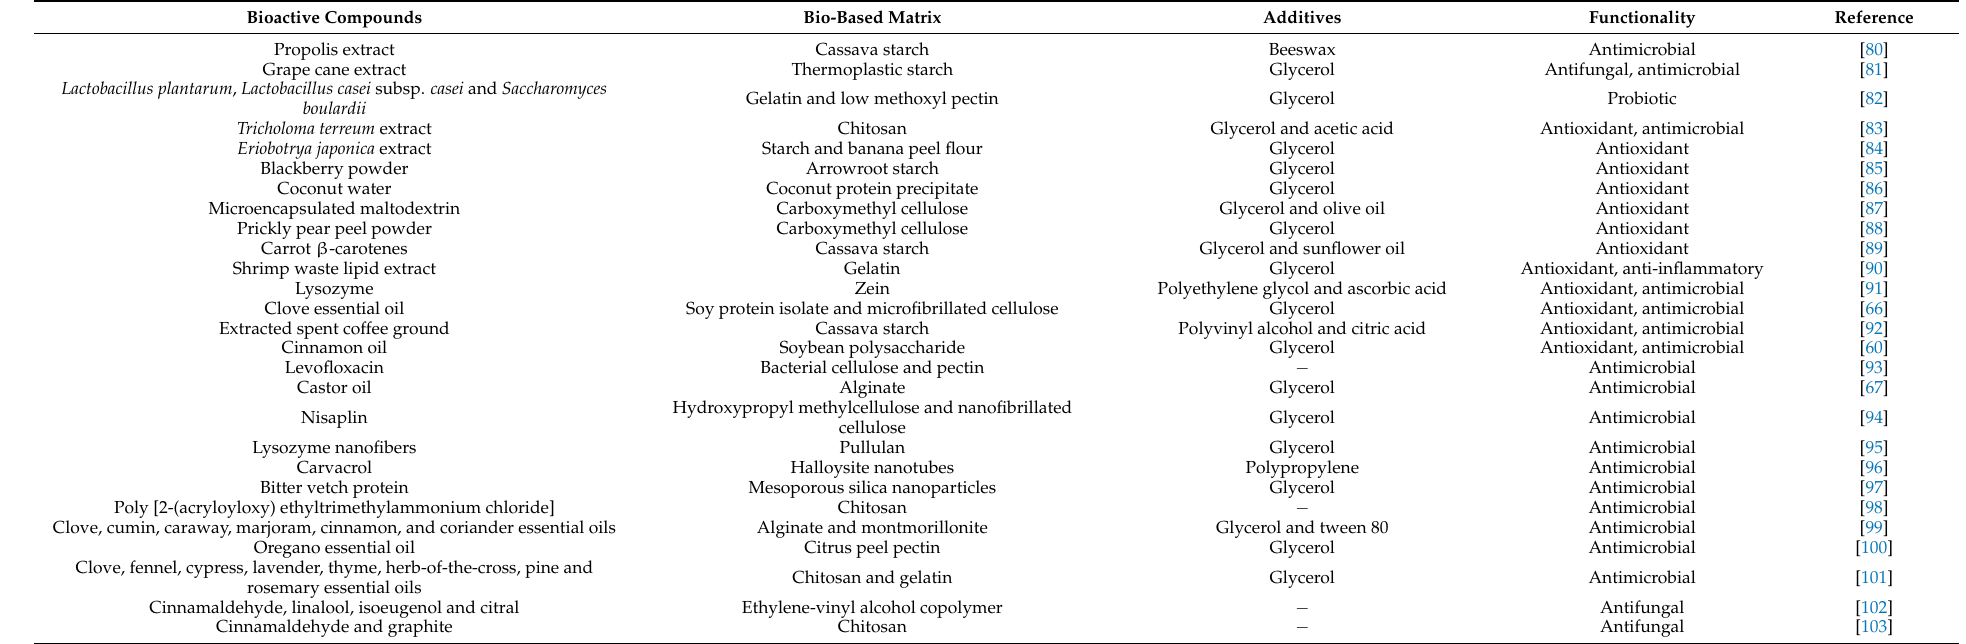
Table 3. Edible films containing different types of bioactive compounds and natural